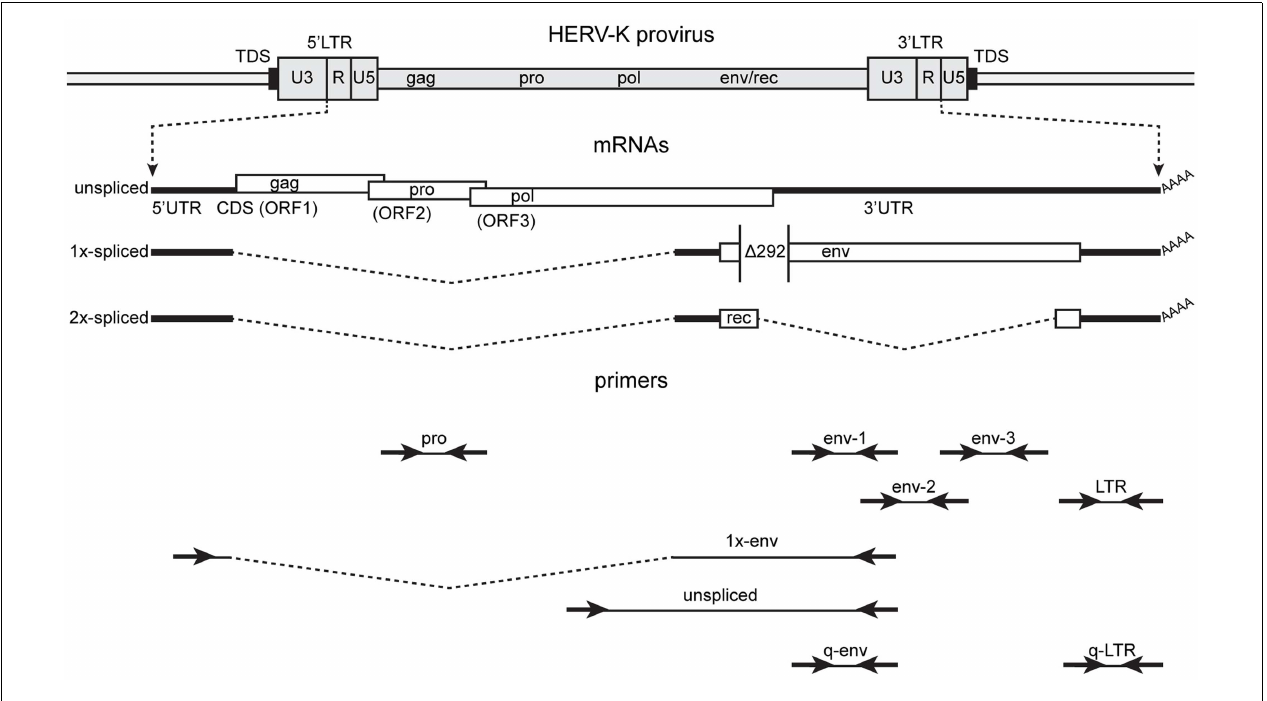
indicated (AAAA).The env mRNA shows the position of the 292-nt deletion ( ∆ 292) of type I HERV-K proviruses that spans the pol-env junction.Type II HERV-K provirus transcripts contain these nucleotides. Positions of the PCR primer pairs are shown at the bottom with the names by which they are identified throughout the paper.The dashed, angled line shows the excised intronic sequences that the 1 × -env primer pair was designed to